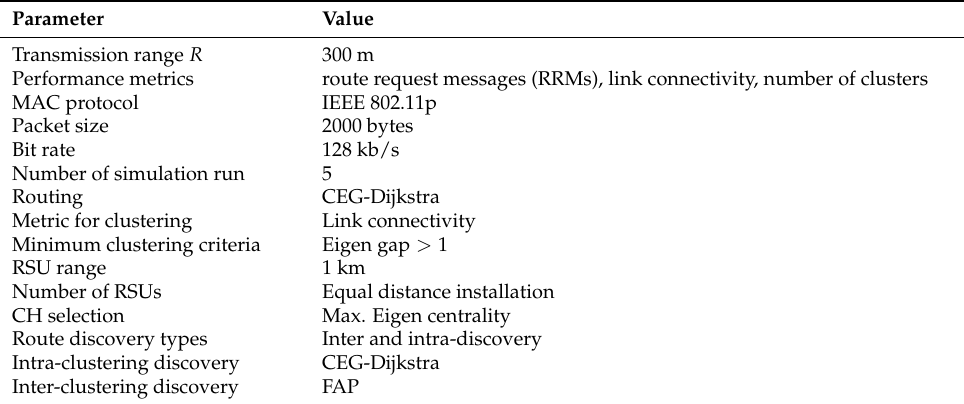
Table 2. Network simulation specification or routing